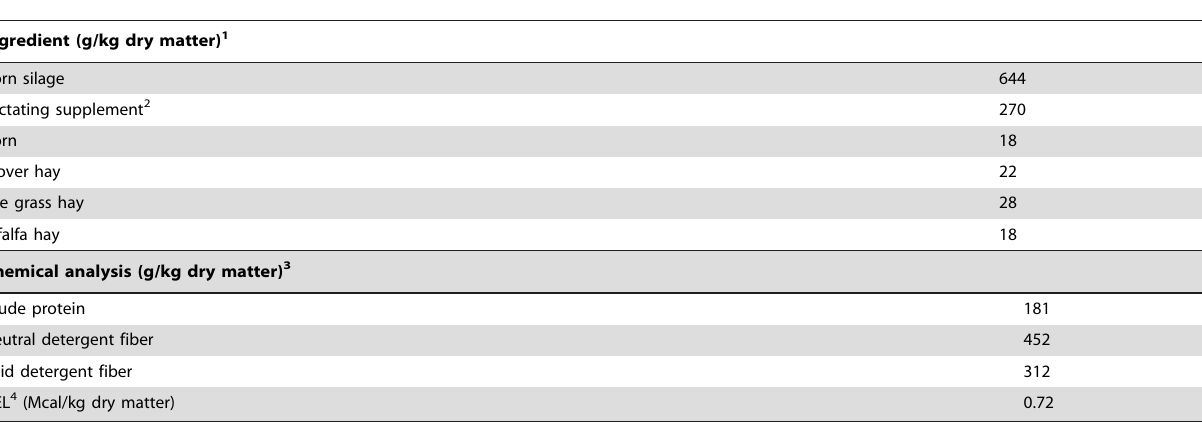
Table 1. Ingredient and chemical composition of total mixed